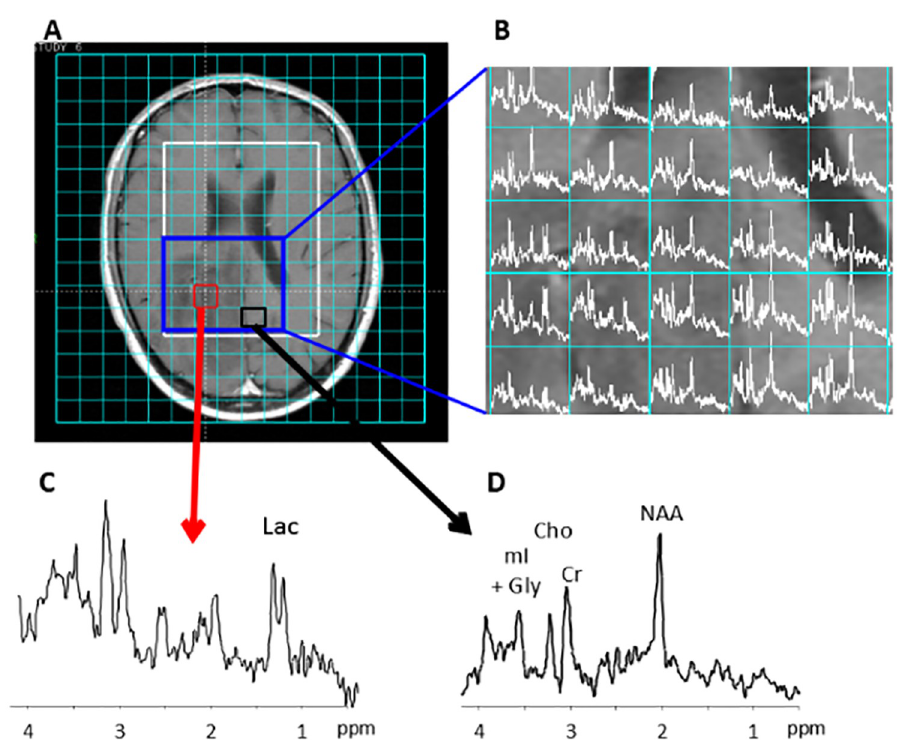
Fig 1. 1 H MRSI of the brain of a patient with a low grade glioma. (A) Post gadolinium T1 weighted MRI. The tumor appears as low intensity signal on the image. The 1 H MRSI acquisition grid is shown on top of the image with the selected region of interest (white box). (B) Map of 1 H MR spectra from selected box (blue) covering the tumorous area. (C) 1 H MR spectrum of voxel in tumor. (D) 1 H MR spectrum of voxel from an apparently benign brain area. The resonances of the methyl protons of lactate (Lac); N-aspartylaspartate (NAA); creatine (Cr) and choline (Cho) are indicated together with those of protons of myo-inositol (mI) and glycine (Gly).